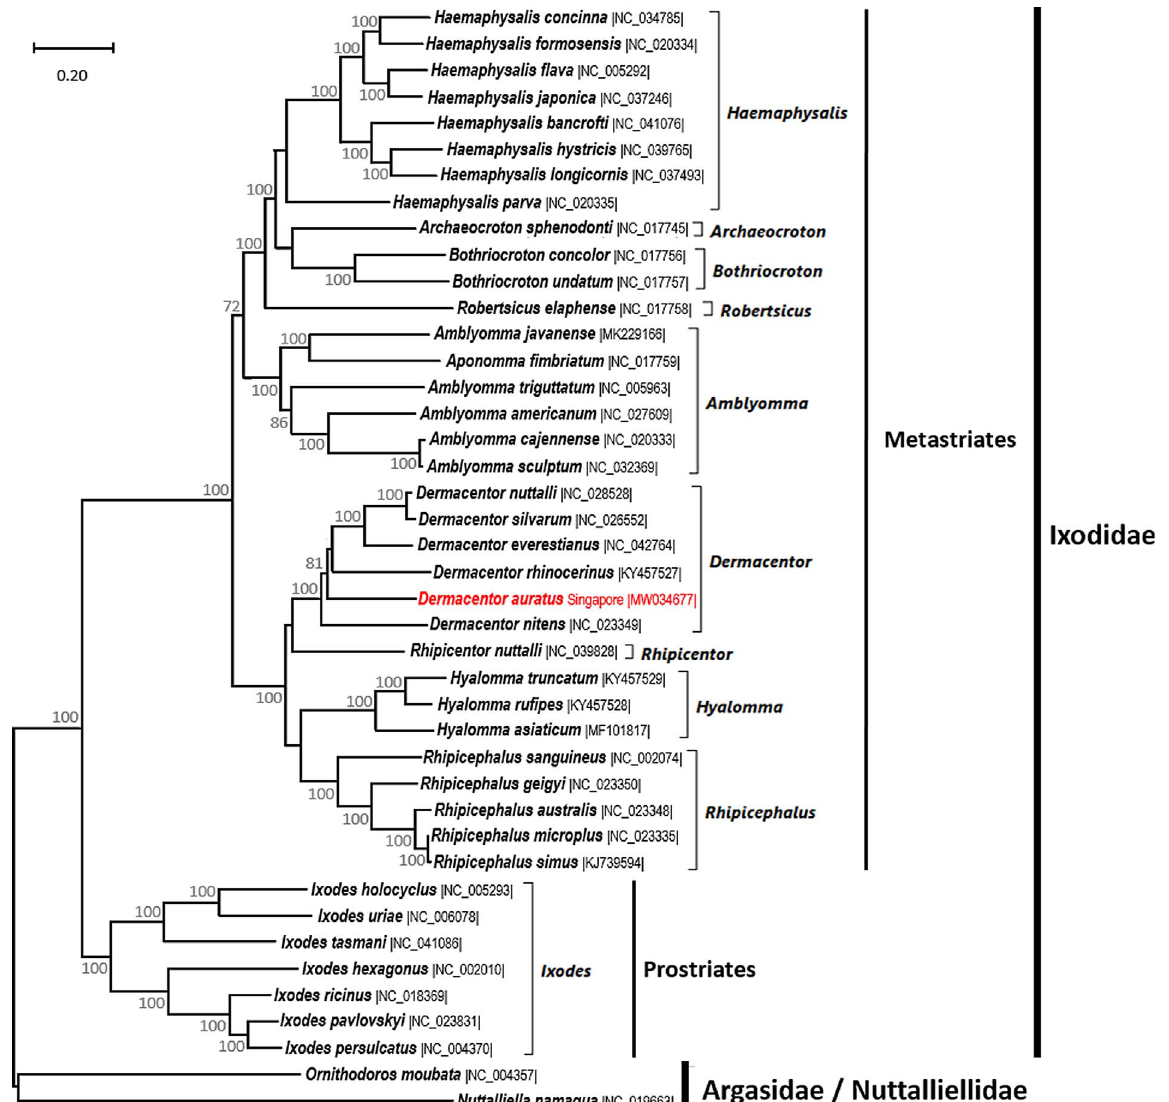
Figure 3. Maximum likelihood phylogeny inferred on the mitochondrial genomes of Dermacentor ( Indocentor ) auratus obtained in this study (MW034677) (highlighted) and 41 other tick mitochondrial genomes retrieved from GenBank. Accession numbers of the sequences are provided between vertical bars. The mitogenomes of the Argasidae and Nuttalliellidae were used as outgroups to root the tree. The ML analysis used the GTR + C + I model of evolution [26]. Reliability of tree topology, branch support and nodal robustness were assessed by non-parametric bootstrap using 1000 replicates (only >70% shown). Analysis performed with MEGA X